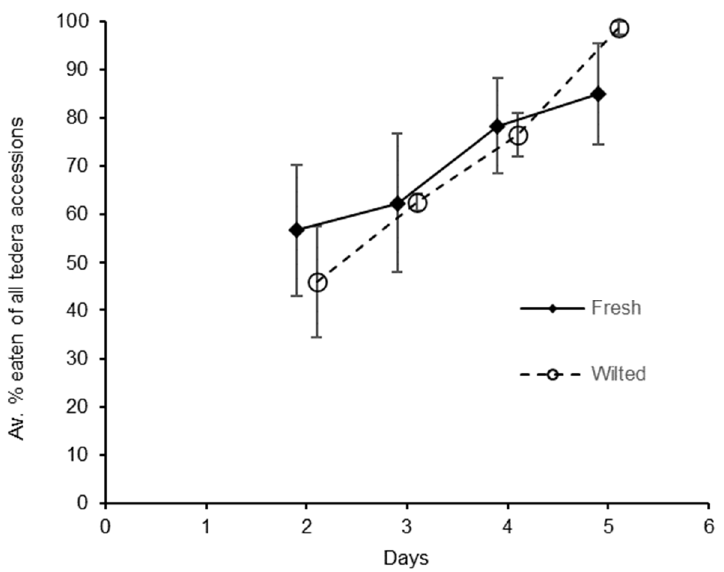
Figure 6. The average percentage of the tedera offered that was eaten in the first hour by naive sheep fed fresh (diamond) and wilted (circle) tedera over four days of experiment 2. Note: Error bars are standard errors.